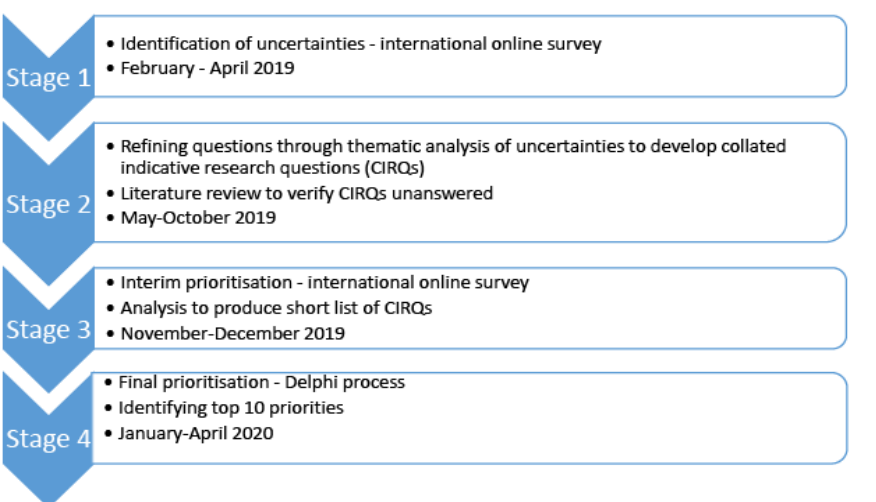
Figure 1. Flow chart of the 4 key stages of the James Lind Alliance methodology as applied to the Canine Surgical Sterilisation Priority Setting Partnership.